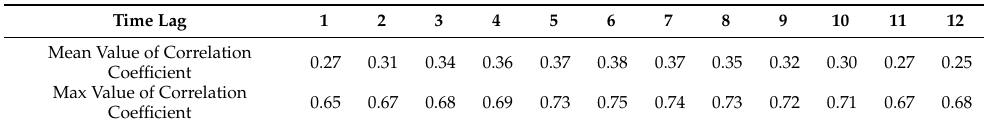
Table 2. Extraction results of the mean and maximum values of the correlation coefficients between the VCI and Niño 3.4 in different lag